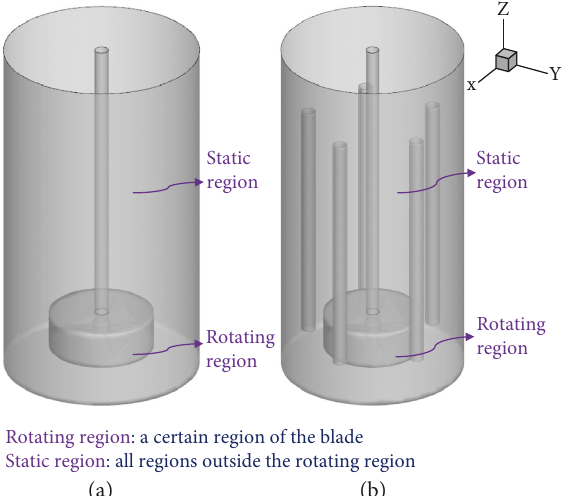
Figure 3: The division of rotating and static region. (a) Traditional chromite leaching stirred reactor. (b) Dynamic-static combined chromite leaching stirred reactor.